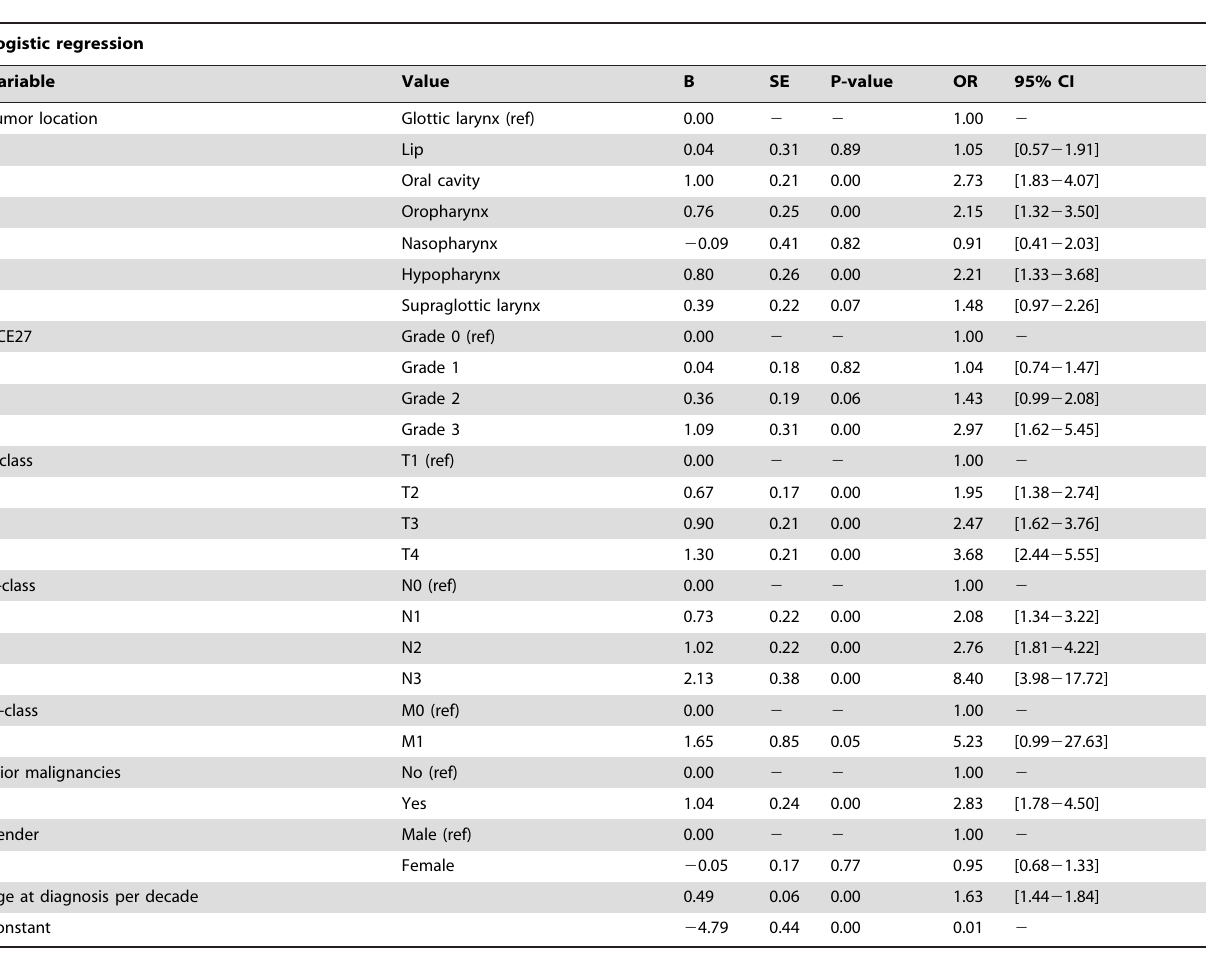
Table 7. Logistic regression model for the outcome ‘dead or alive at 60 months’.